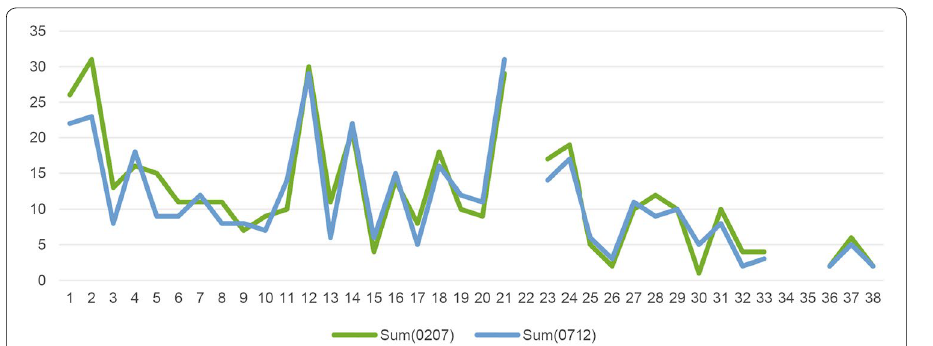
Fig. 4 Aberrant key coefficients in each